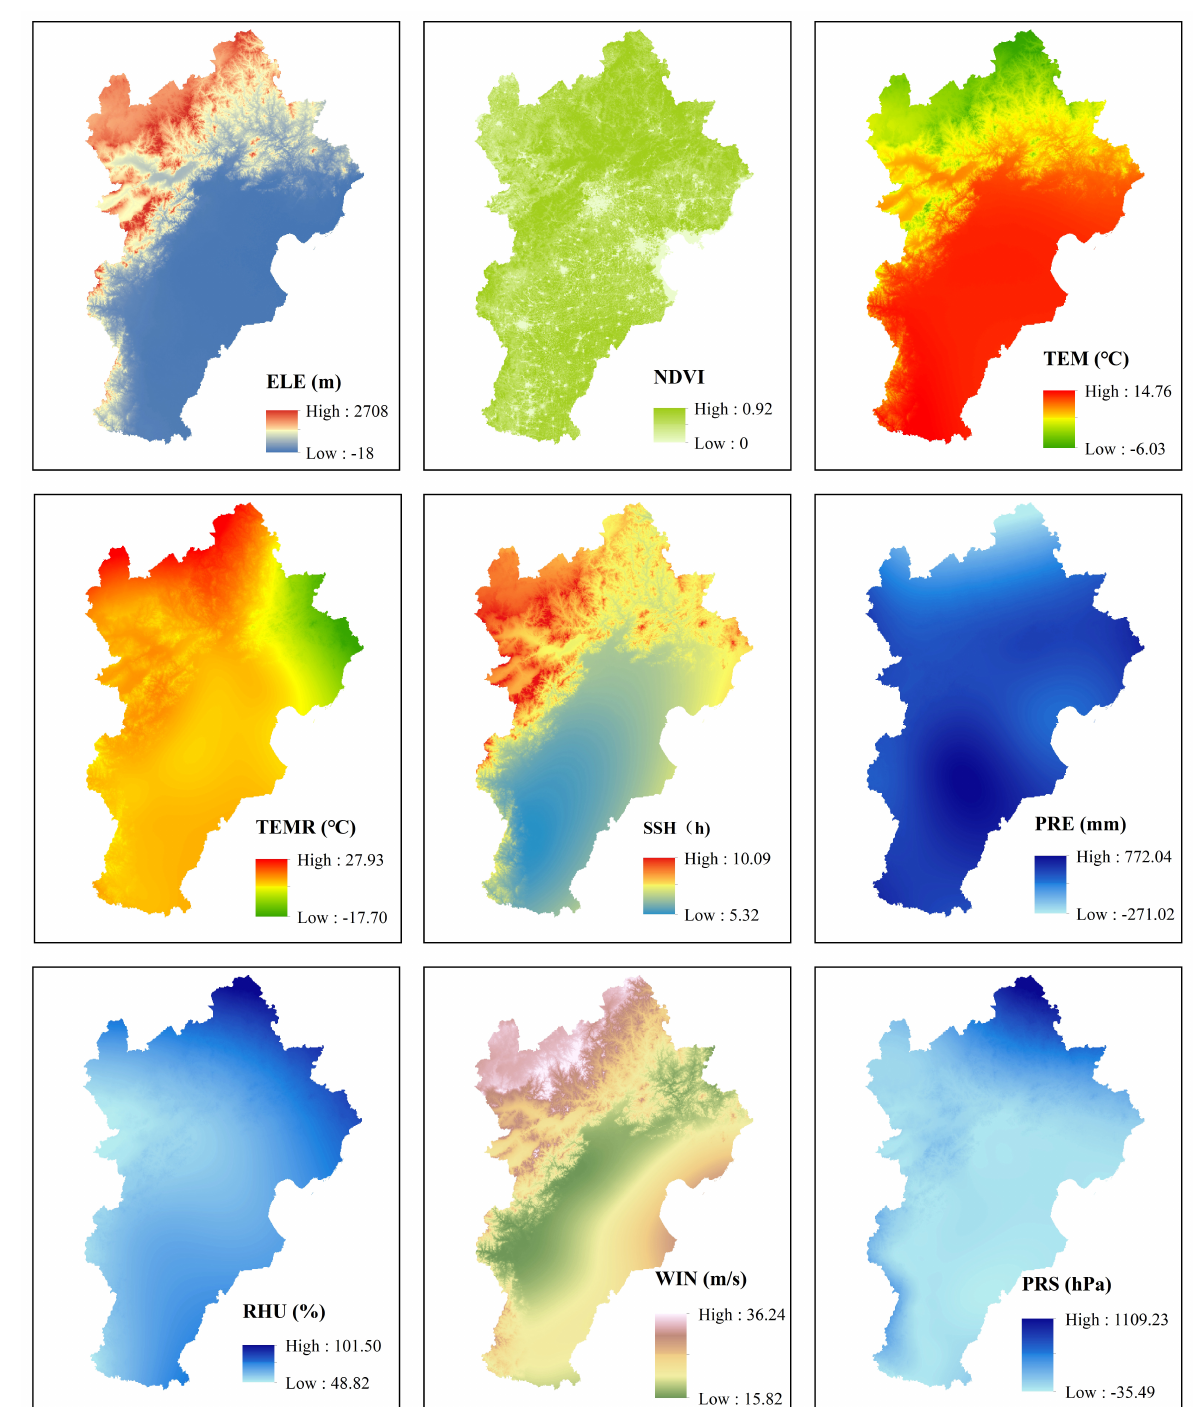
Figure 1. Distribution of natural elements in the Beijing–Tianjin–Hebei urban agglomeration (BTH) (taking 2016 as an